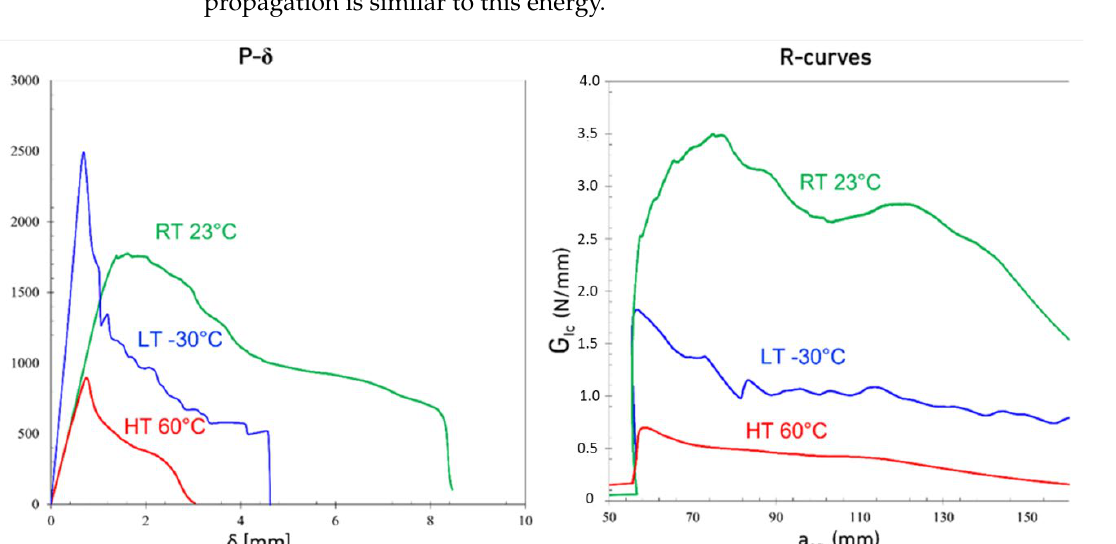
Figure 4. Representative Load-displacement and R-curves of DCB joints under speed loading rates (200 mm/min) at different temperatures.